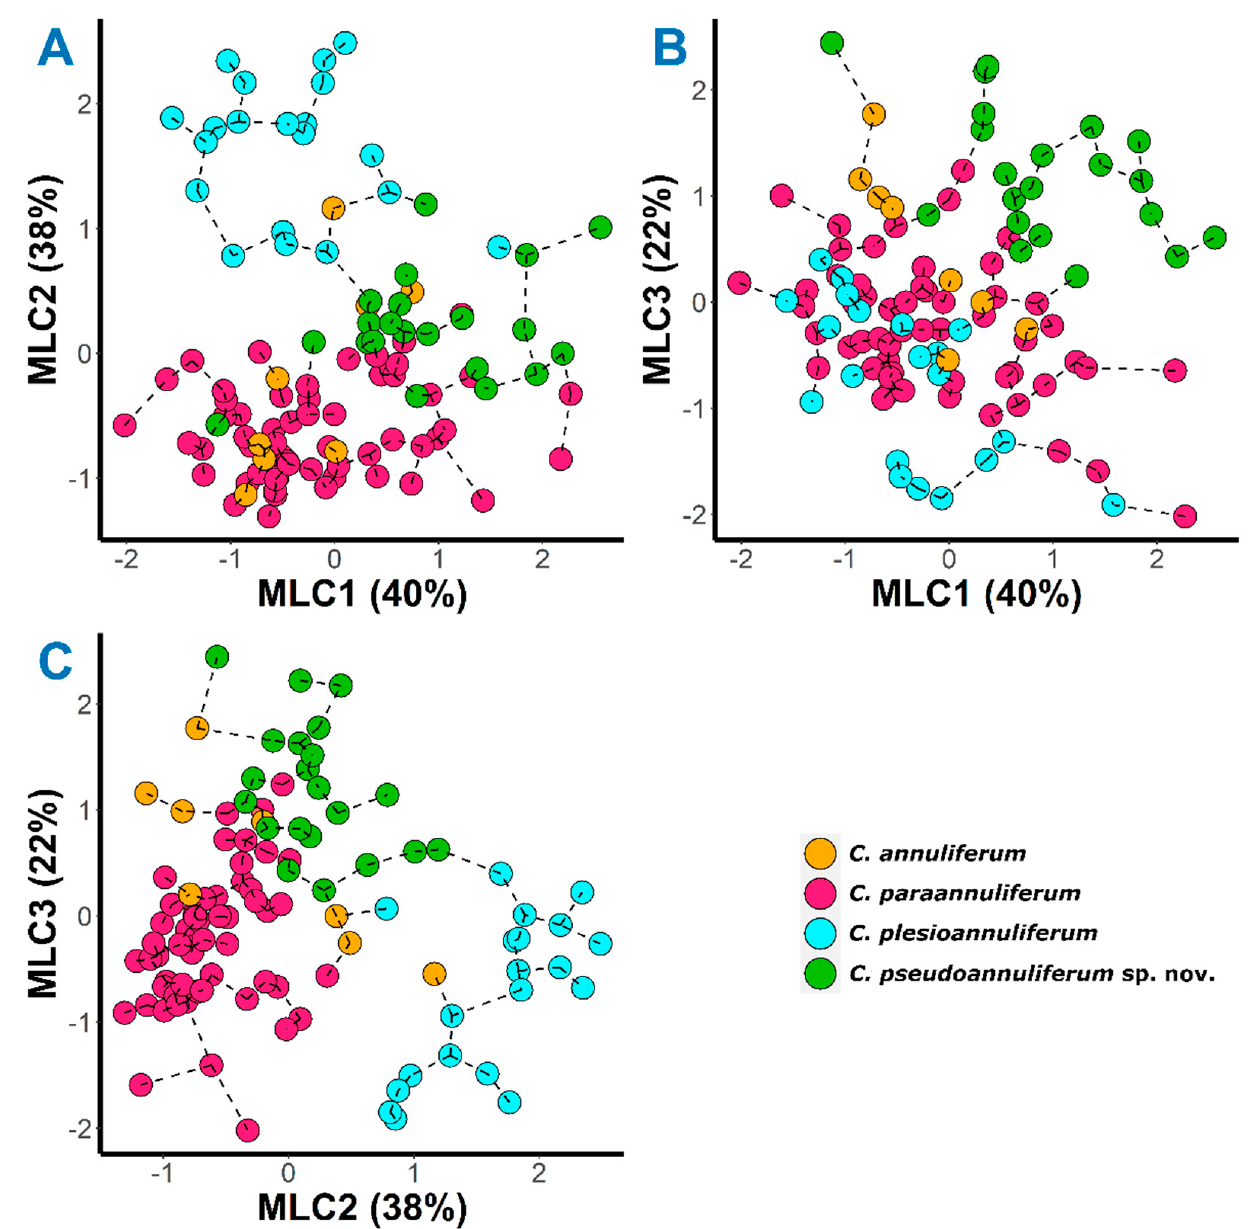
Figure 1. Factor analysis with a superimposed minimum spanning tree on Criconema annuliferum species complex. ( A ), maximum likelihood component 1 (MLC1) vs. maximum likelihood component 2 (MLC2); ( B ), maximum likelihood component 1 (MLC1) vs. maximum likelihood component 3 (MLC3); ( C ), maximum likelihood component 2 (MLC2) vs. maximum likelihood component 3 (MLC3).